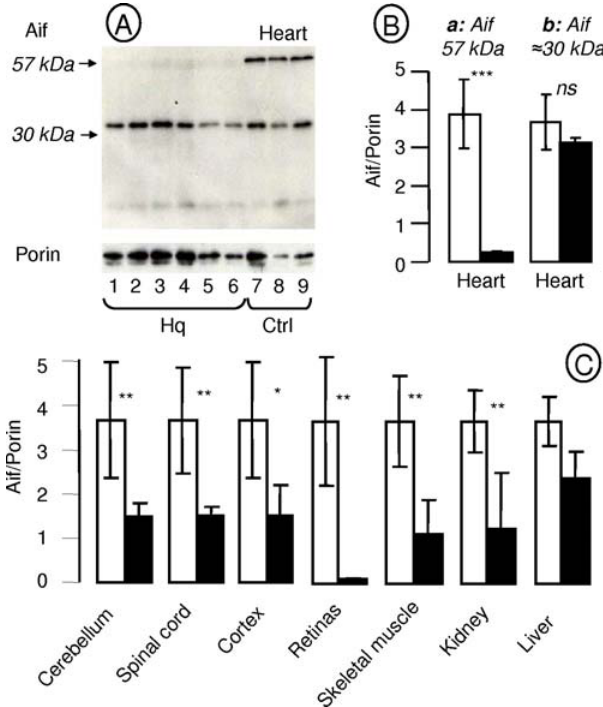
Figure 7. Aif in Harlequin mice. A: Western blot analysis of Aif in the heart of Hq mice (lines 1–6) and control mice (lines 7–9). In the heart, two bands reacted with the Aif antibody. The band with the highest molecular weight was produced by the Aif1 isoform (molecular weights of the unprocessed and processed forms, 67 and 57 kDa, respectively). The molecular weight of the other band is consistent with the Aif sh2 isoform. This second form was not detected in any of the other tissues studied (cerebellum, spinal cord, cortex, retinas, skeletal muscle, kidney, or liver). Porin was used as a loading marker. B: Proportion of the two Aif isoforms identified in the heart of control mice (open symbol) and Hq mice (dark symbol) mice. C: Aif (57 kDa) content in various tissues of control and Hq mice normalized for porin content. ** p , 0.005; *** p , 0.001.